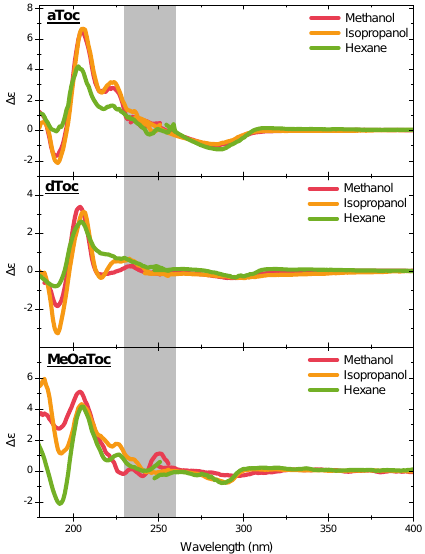
Figure 4. The measured CD spectra for α , δ , and methylated α -tocopherol (aToc, dToc, MeOaToc) in different solvents. The data are stitched together from two measurements (different wavelengths and pathlengths) by overlapping the common energy region between 230 and 260 nm (grey band). The line thickness corresponds to the error associated with the different